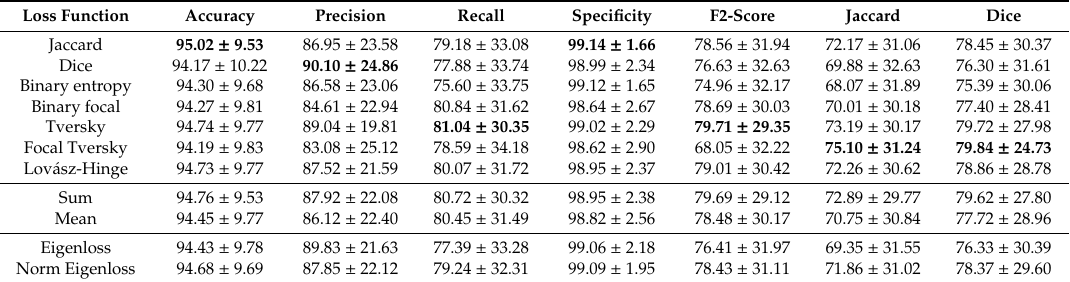
Table 2. U-Net-Densenet121. Results of the model trained with the di ff erent loss functions, reported over the test set of CVC-EndoSceneStill. Best values are indicated in